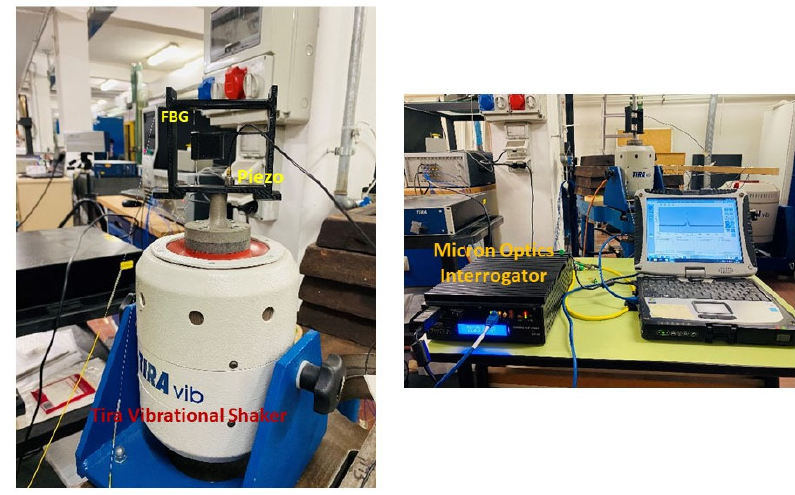
Figure 5. Laboratory calibration test of FBG system with a mechanical shaker.